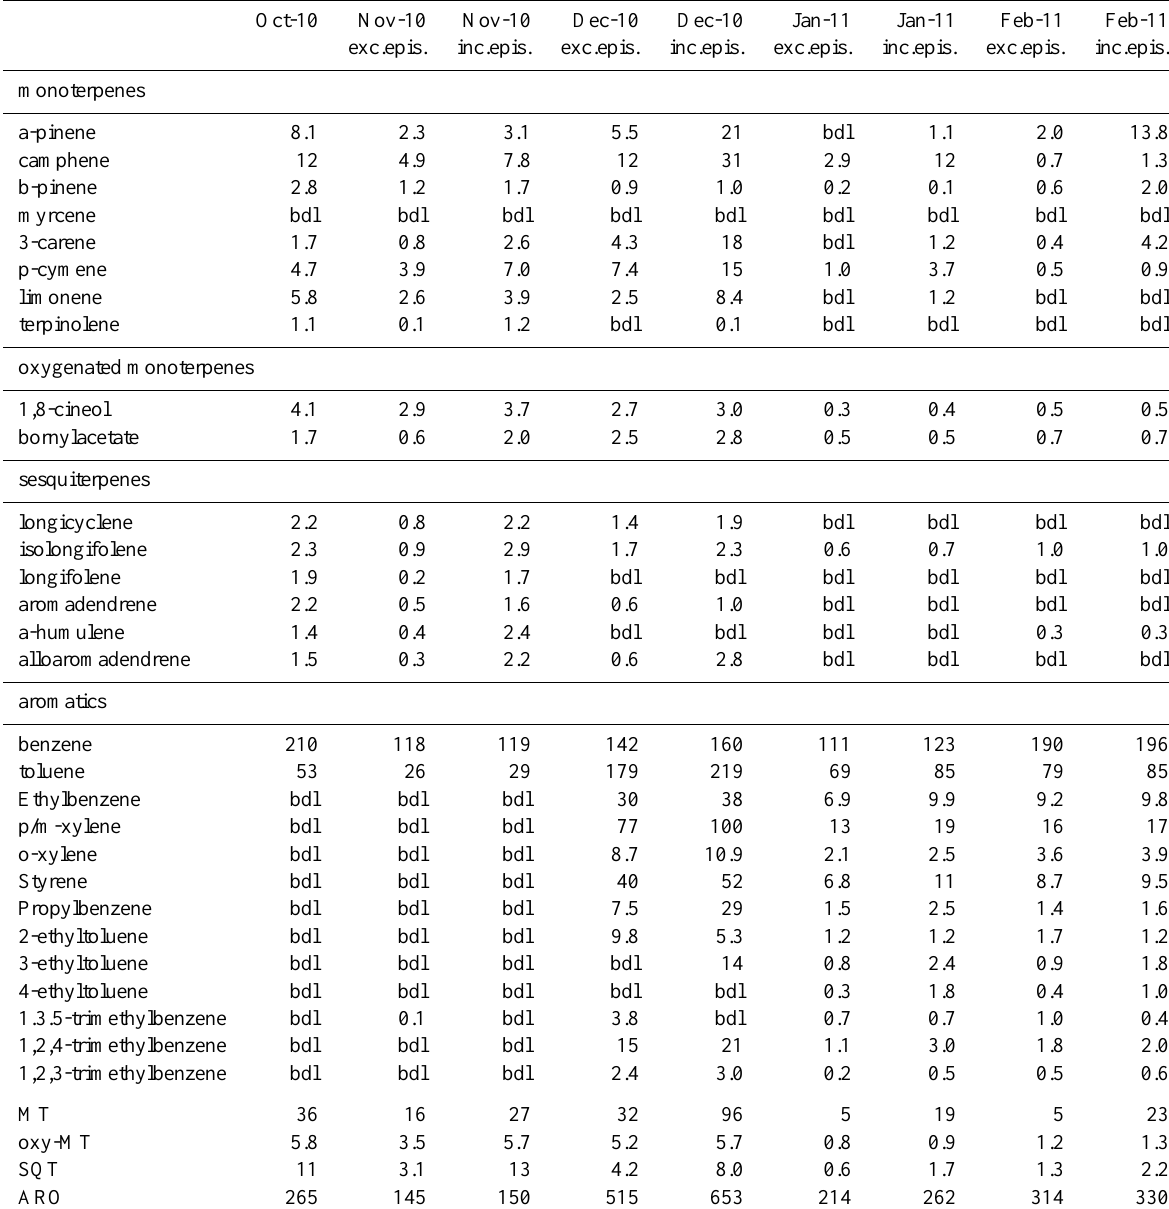
Table A1. Monthly mean mixing ratios of VOCs (ppt). The months with high episodes mean values are calculated separately including and excluding the episodes. Sesquiterpene mixing ratios were not available in June and July due to bad